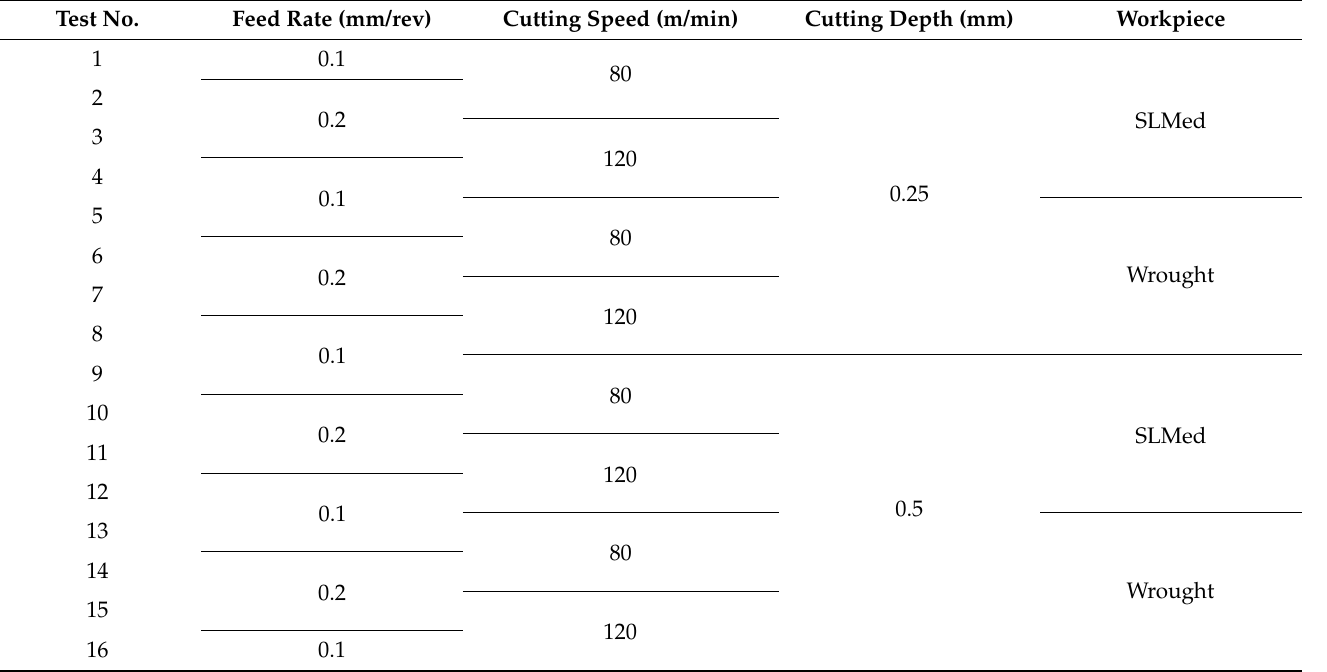
Table 3. Cutting parameters of the turning experiment.